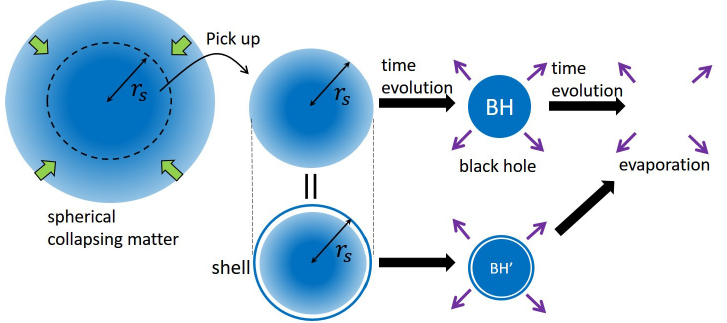
Figure 3. Time evolution of a part of a spherical collapsing